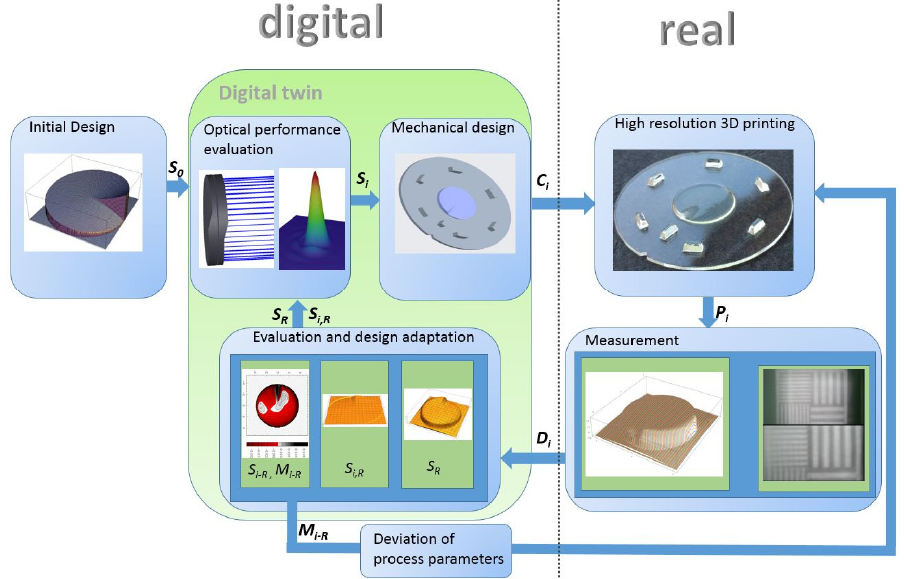
Figure 2. Simplified visual illustration of digital twin and process